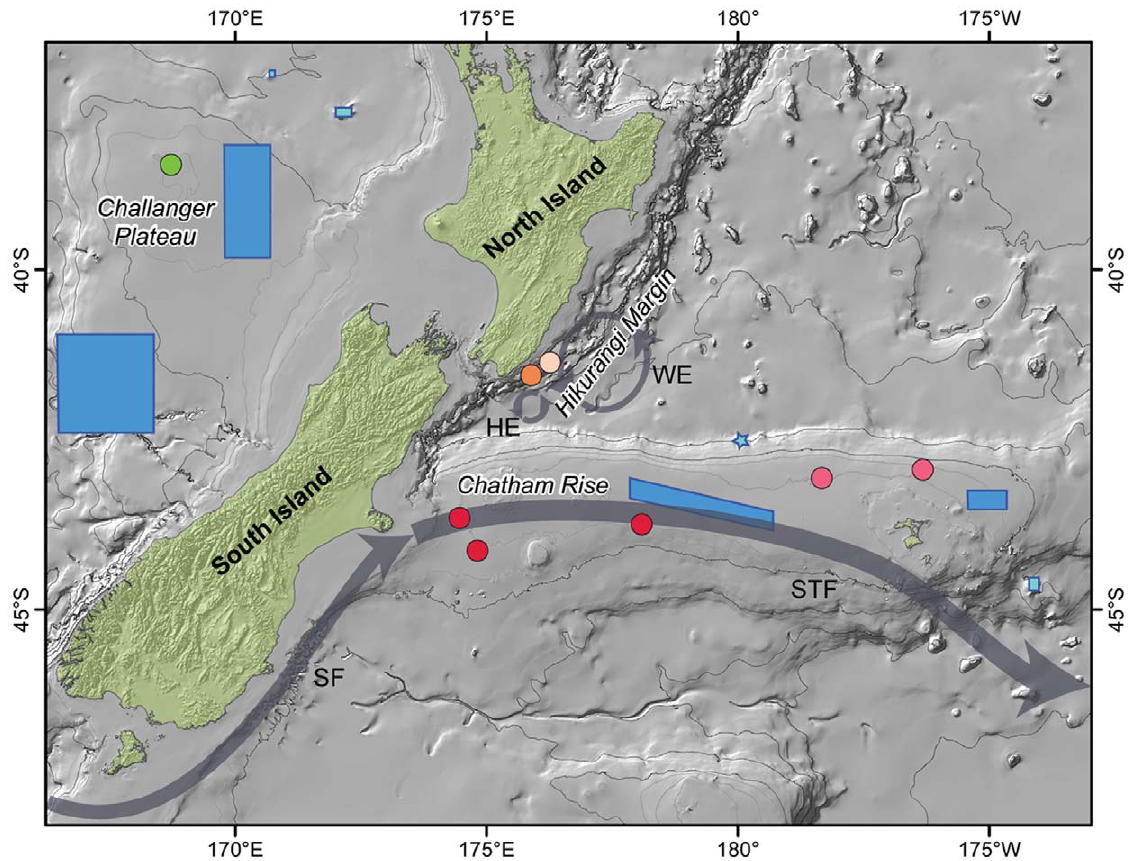
Figure 7. Map of the study area showing genetically distinct populations (colored circles) of the worm H.longibranchiata relative to the position of Benthic Protection Areas (blue) and seamount closures (light blue), and local currents. Populations on the Challenger Plateau, Hikurangi Margin and Chatham Rise are green, orange, and red, respectively, with different shades of the latter two colors representing within region differences in genetic population structure. Blue rectangles represent Benthic Protection Areas and Seamount Closures (in light blue). The star marks two Seamount Closures too small to be visible on the map. The approximate position of the Southland Front (SF), the Sub-Tropical Front (STF), the Hikurangi Eddy (HE), and Wairarapa Eddy (WE) are shown with grey bands and arrows. The location of the STF is based on Figure 1 of Hayward et al. (2008) [76].